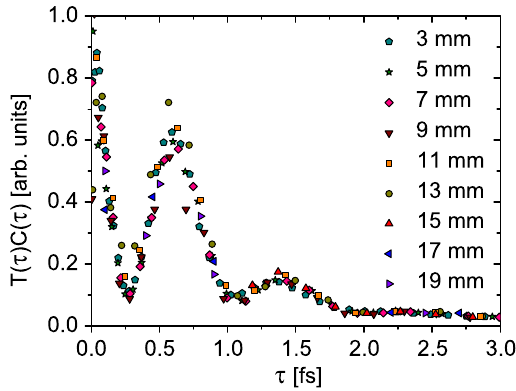
FIG. 16. Broadband power spectra fit the master curve under the scaling of Eq. (13). The 9 probed distance are indicated in the figure legend and range between 3 mm and 19